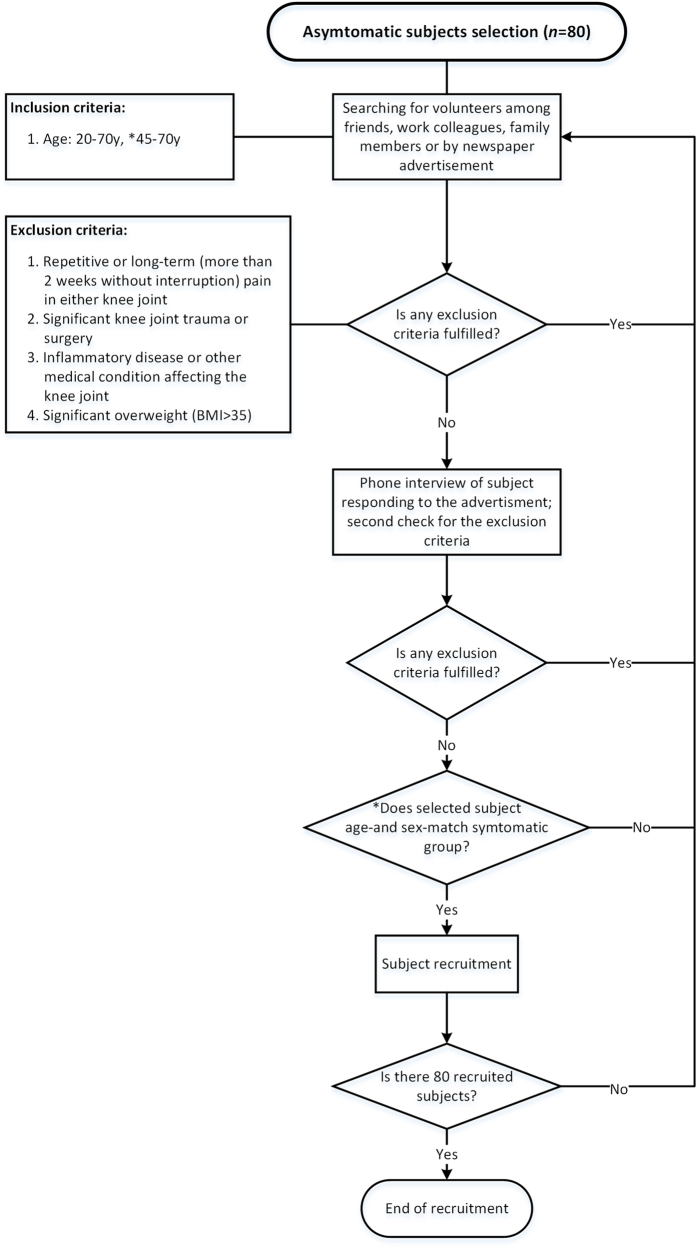
Flowchart describing the selection of asymptomatic subjects.*After pilot examinations of 25 subjects the age range was modified to age-match the symptomatic group.